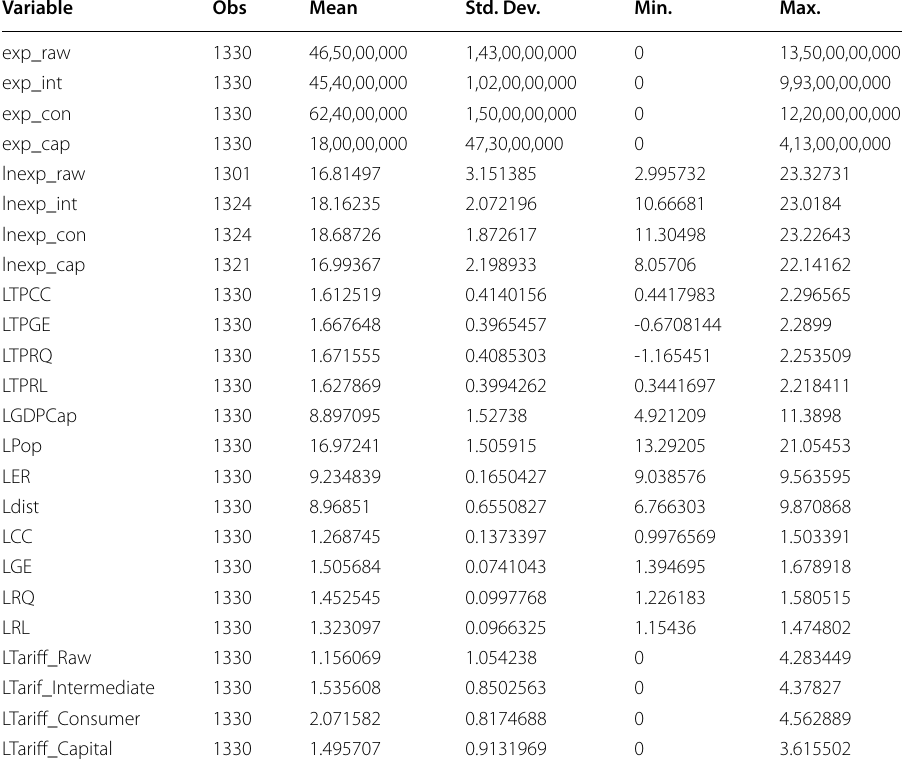
Table 4 Descriptive statistics. Source: authors’ calculation Variable Obs Std.